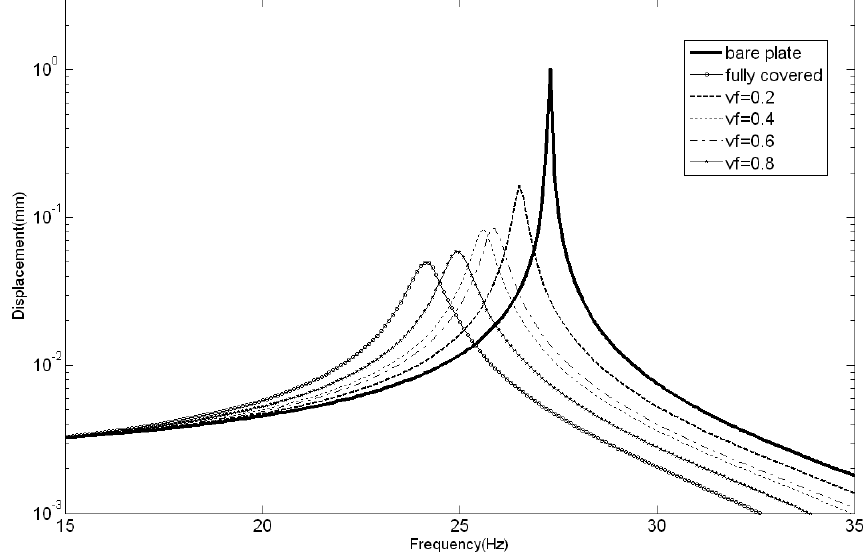
Fig. 27. The first natural